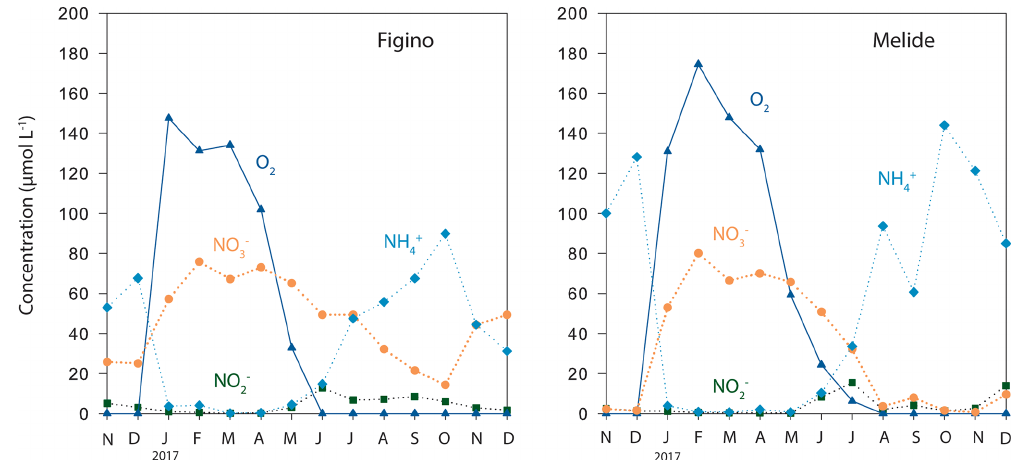
Figure 1. Concentrations of dissolved O 2 and reactive nitrogen in the bottom waters (2m above the sediments) of the Lake Lugano south basin in